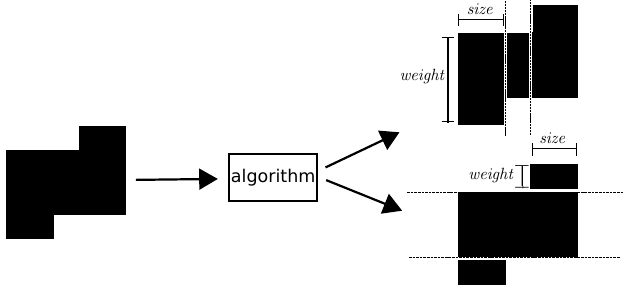
Figure 6. Example of applying our split method into a region (left) output by the Hybrid Segmentation